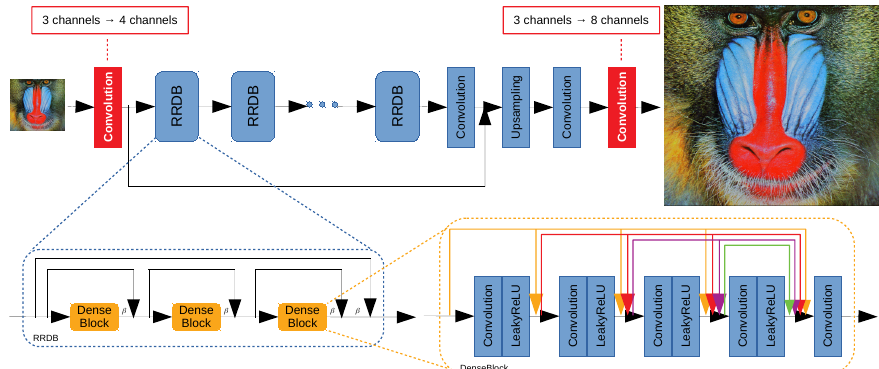
Figure 2. The generator of ESRGAN. Contents in red boxes shows an example of adaptations when taking as input MS image with four